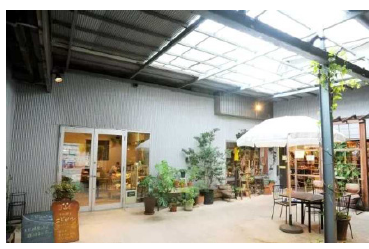
Figure 9. Earth Us (2017, Seoul, Korea).